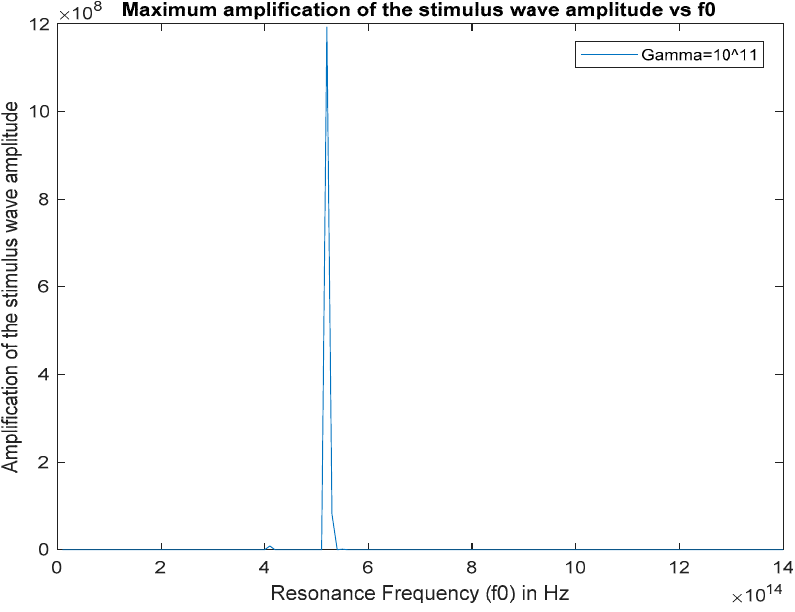
Figure 9. Maximum stimulus wave amplitude (gain factor) inside the cavity at x = 5.73 µ m for 0 < t < 30 ps, γ = 1 × 10 11 Hz, versus f 0 .